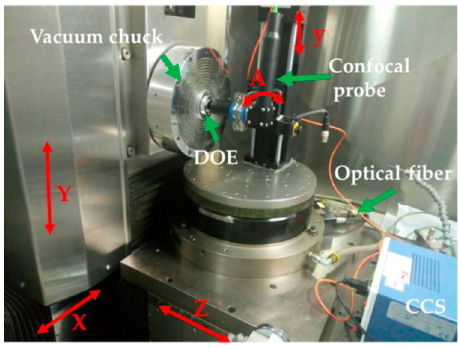
Figure 9. The experimental setup for measuring the curved substrate